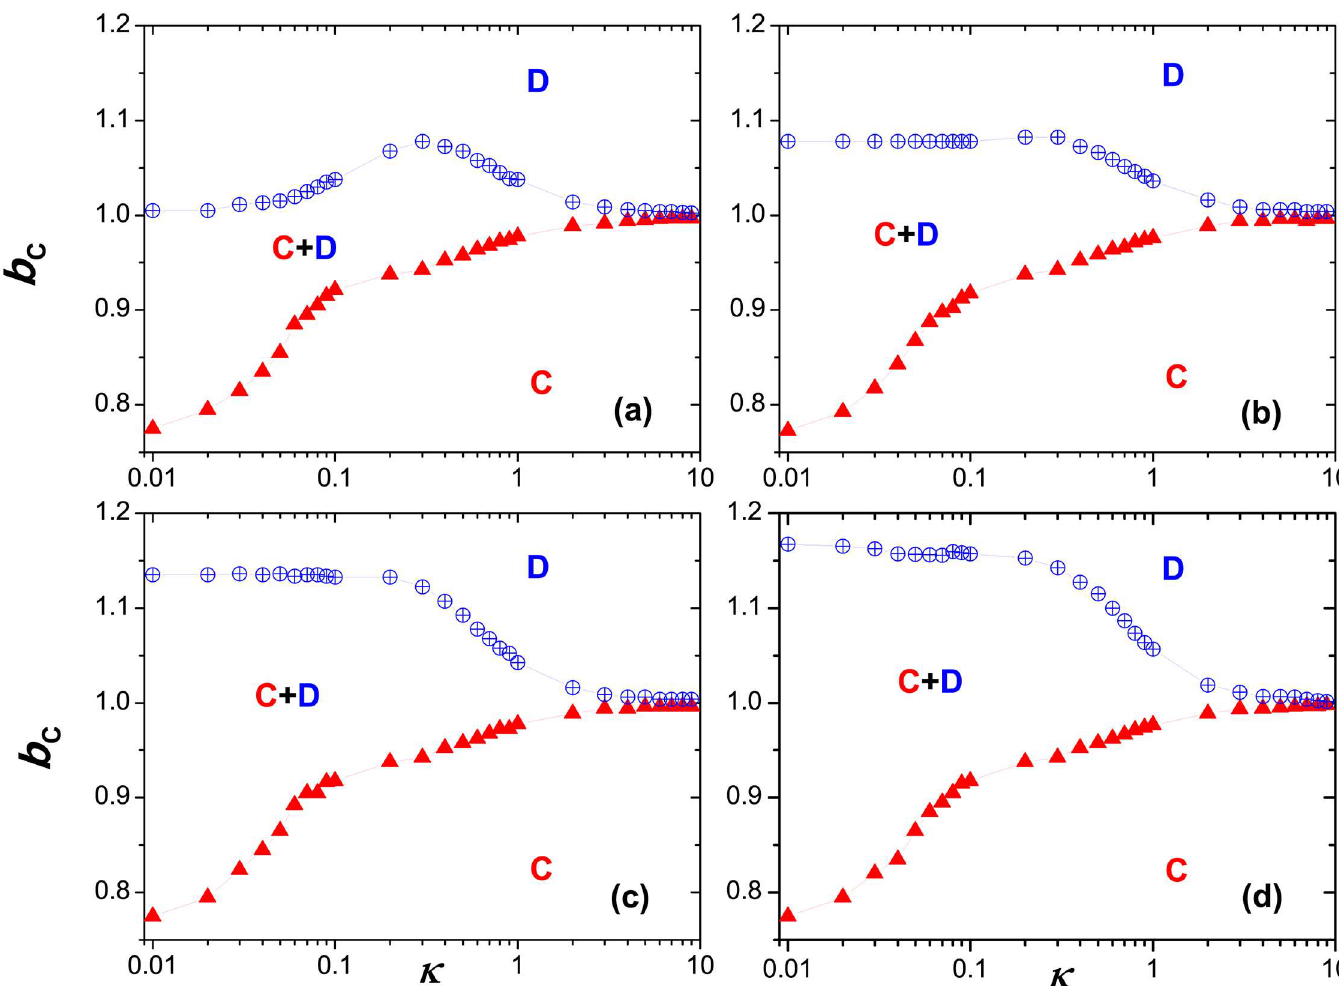
Fig 8. Full b − κ phase diagram. From panel (a) to (d), the tunableparameter is set to be α = 0, 0.4, 0.8 and 1.0, respectively.Here, the yellow crossed circle denotesthe transition between C + D (coexistence phase) and D (full defection), and the read upper trianglerepresents the transition between C + D and C (full cooperation). The system setup is assumed to be L = 200, MCS = 5 × 10 4